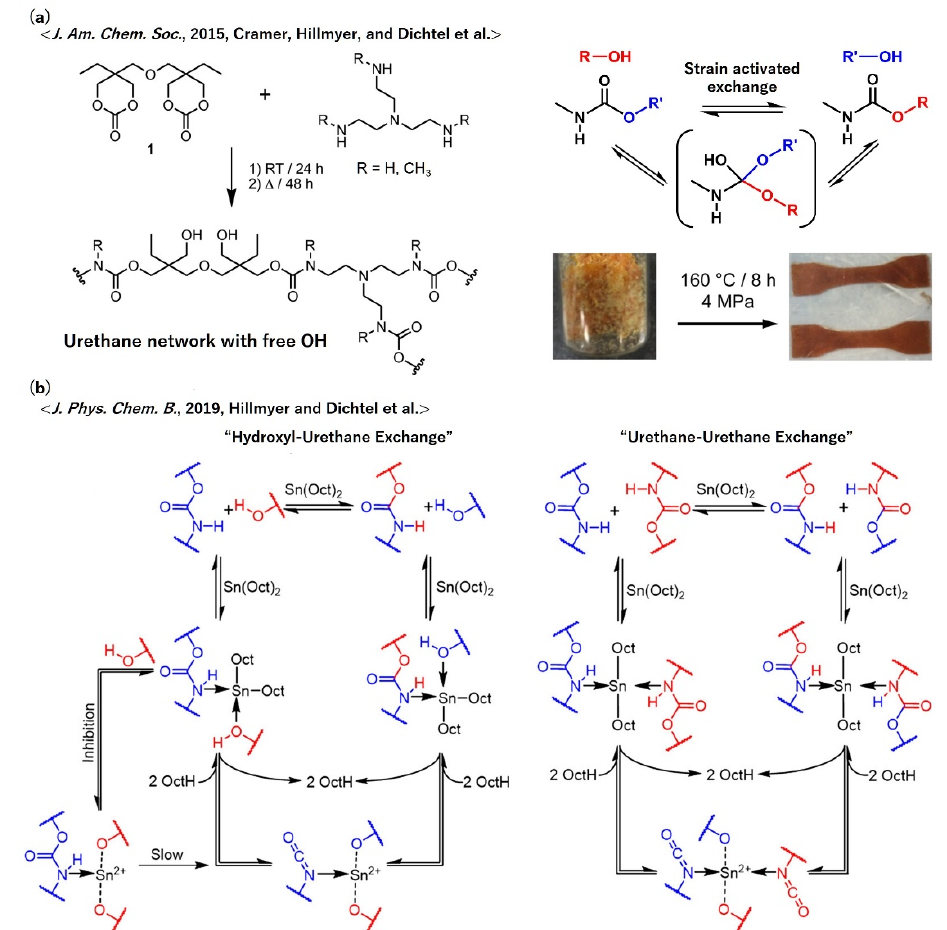
Figure 14. ( a ) Molecular design of vitrimer polyurethane according to ref. [61], where the mechanism of transcarbomoylation and a visual representation of recyclability are also shown. ( b ) Proposed mechanism of urethane reversion depending on the presence or absence of the metal catalyst, stannous octoate (Sn(Oct) 2 ), according to ref. [63]. ( a ) Adapted with permission from ref. [61]. Copyright (2015) American Chemical Society. ( b ) Reprinted with permission from ref. [63]. Copyright (2019) American Chemical Society.